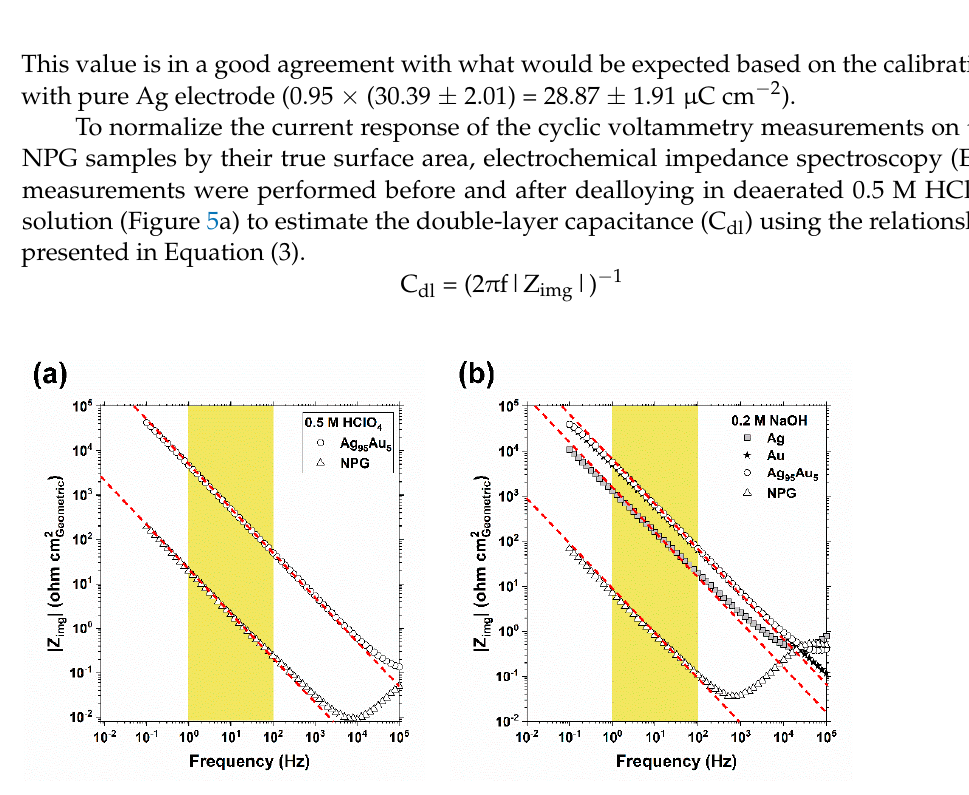
Figure 5. The dependence of the absolute value of the imaginary component of impedance (|Z img |) against frequency measured by EIS at OCP in ( a ) 0.5 M HClO 4 ; and ( b ) in 0.2 M NaOH for NPG and on the flat surfaces of Ag, Au, and Ag 95 Au 5 electrodes. The red dashed lines indicate a slope of − 1.